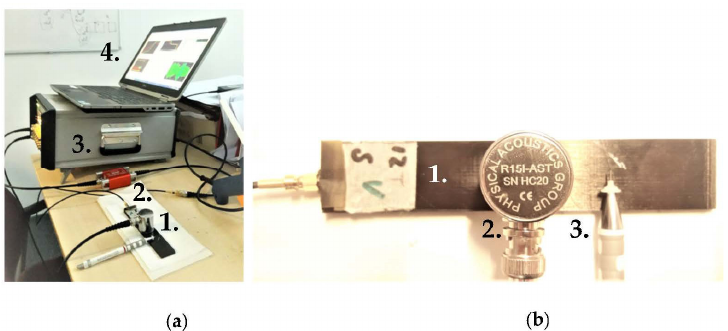
Figure 2. Set ‐ up for exciting and measuring a Hsu ‐ Nielsen source [36]: ( a ) Overview of the set ‐ up, with the numbers 1 to 4 corresponding to the specimen, AEP ‐ 5H preamplifier, AMSY6 data acquisition system and a measurement computer. ( b ) Close ‐ up showing the specimen (1.), AE sensor R15I ‐ AST (2.) and a mechanical pencil with Nielsen shoe (3.). Note that in the final assessment a pencil with 0.5 mm diameter lead was used at a distance of 60 mm from the centre of the sensors.